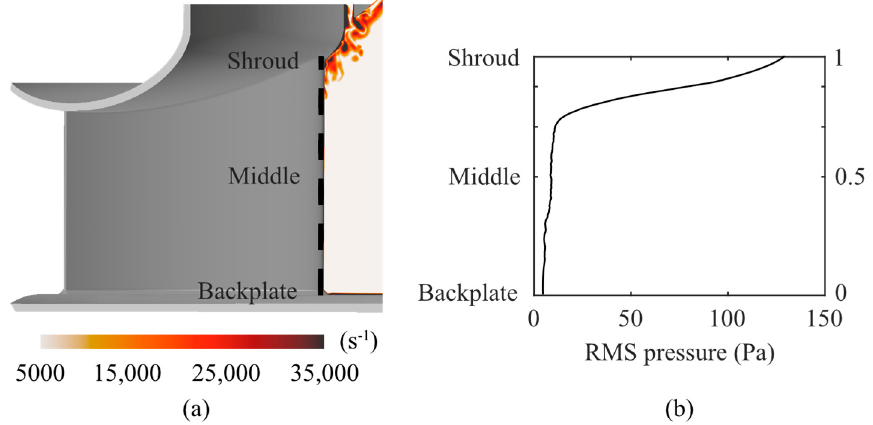
→ Figure 3. Turbulence at the BLE: ( a ) Vorticity magnitude ‖𝜔(cid:4652)(cid:4652)⃗‖ at one blade. The black dashed line marks the monitoring line at the BLE; ( b ) the RMS of the pressure fluctuations with respect to the normalized length along the monitoring line.